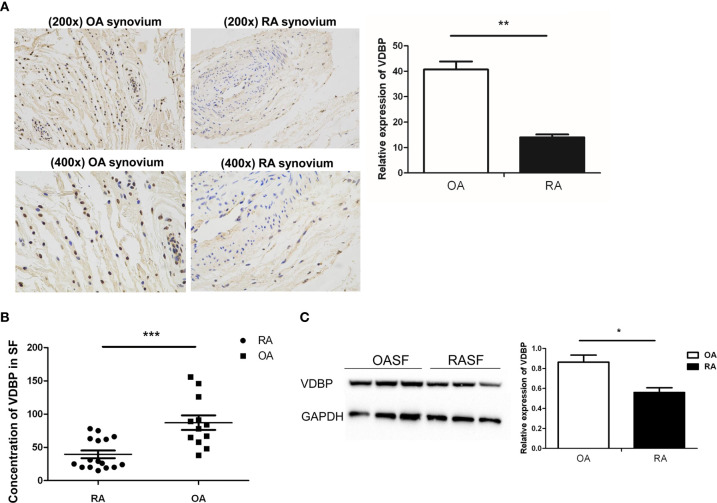
Analysis of Vitamin D-binding protein (VDBP) expression. (A) Expression of VDBP in synovium of osteoarthritis (OA) and rheumatoid arthritis (RA) patients. Immunohistochemistry was performed to detect VDBP expression. Representative immunohistochemistry results (at 200 x and 400 x magnification) and relative level of VDBP were shown. (B) The level of VDBP in synovial fluid of RA and OA patients. Enzyme-linked immunosorbent assay (ELISA) was conducted to detect VDBP in synovial fluid. (C) VDBP protein level in OASF and rheumatoid arthritis synovial fibroblasts (RASF). Western blot was carried out to detect protein expression in three RA patients and three OA patients. The representative Western blot results and the relative expression of VDBP from western blot were shown. Each lane represents the sample from an individual patient. Several western blots were used for quantification. *P < 0.05, **P < 0.01, ***P < 0.001.